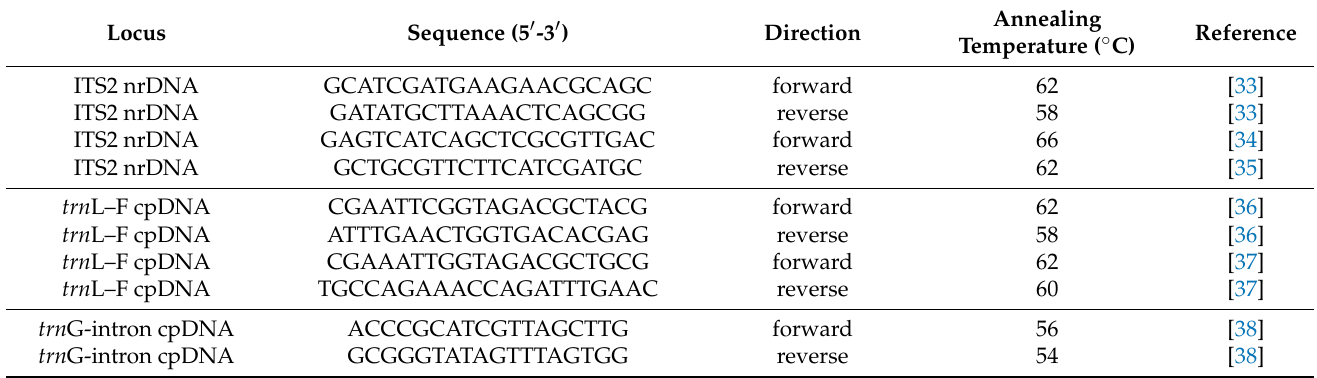
Table 3. Primers used in the polymerase chain reaction (PCR) and cycle sequencing reactions. Locus Sequence (5 (cid:48) -3 (cid:48) ) Direction